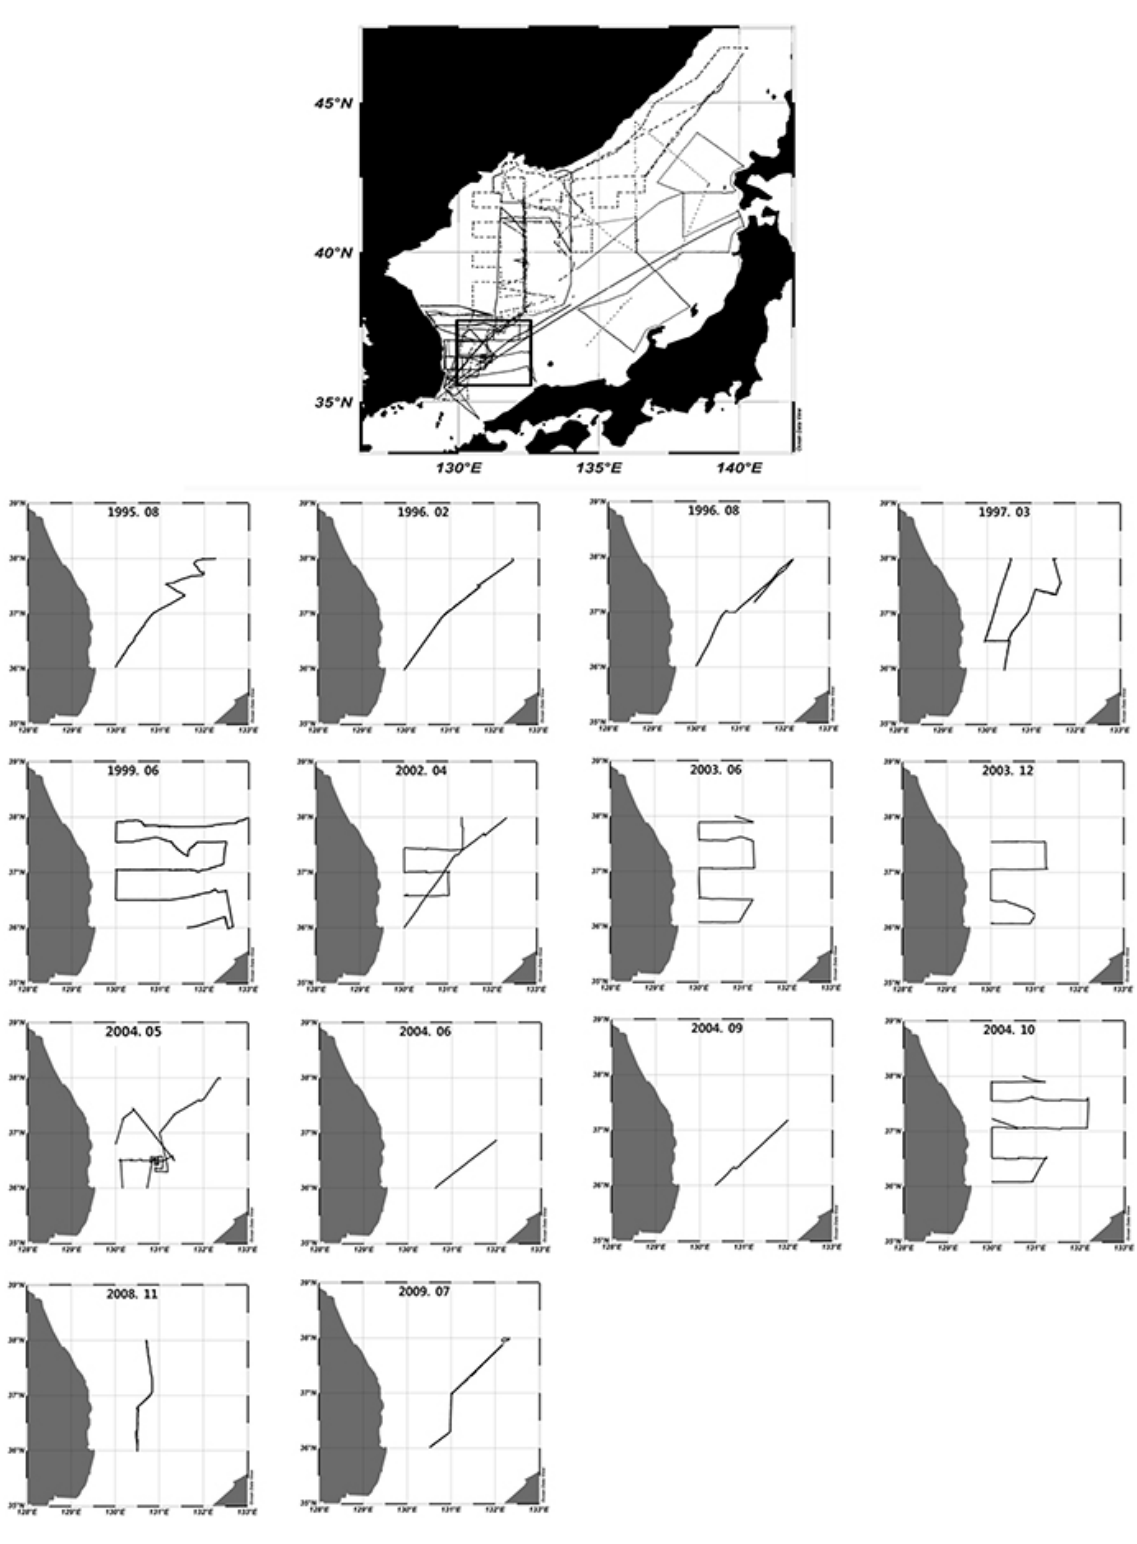
Fig. 1. Maps showing the tracks of the cruises conducted between 1995 and 2009 for this